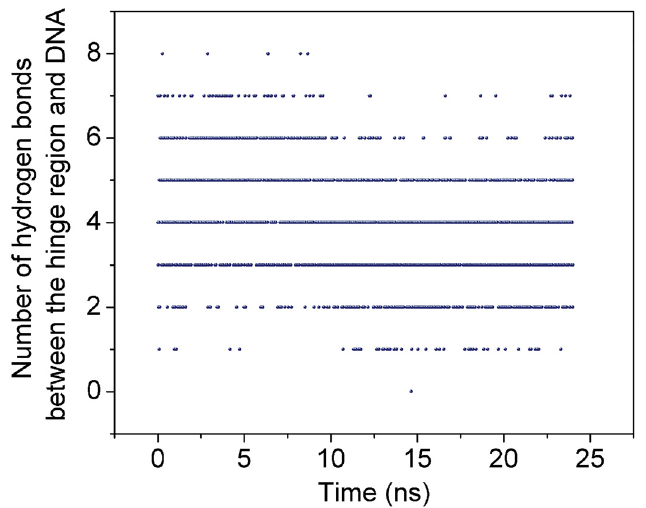
Fig 4. The number of hydrogen bond along the trajectory between the hinge region of the LacI and DNA.